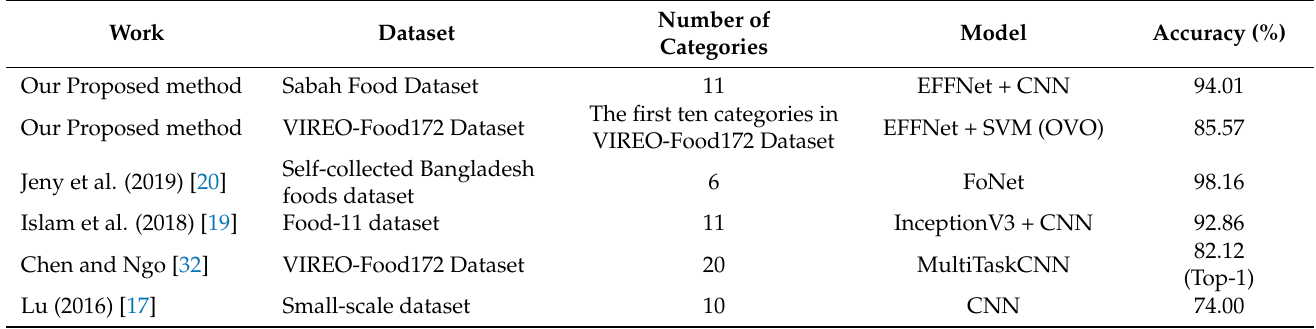
Table 24. A comparison of several food recognition